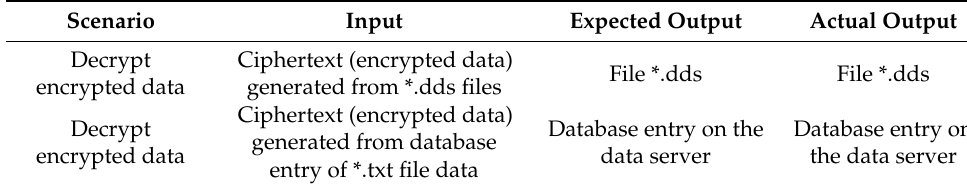
Table 10. Decryption